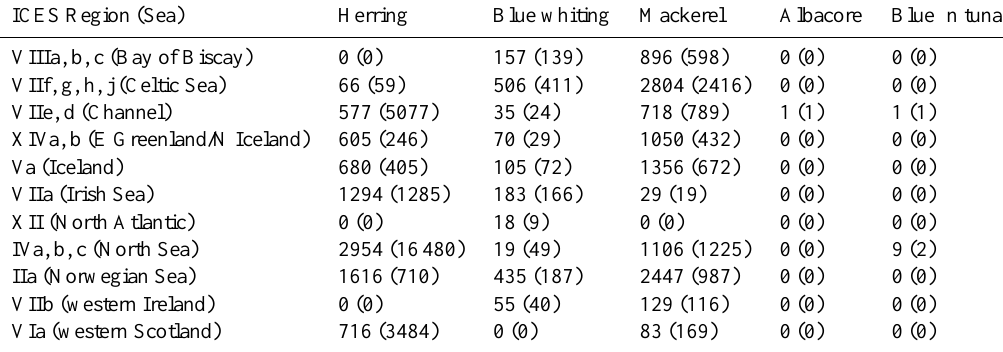
Table 2. Number of records for pelagic fish species submitted to the DAPSTOM stomach content database as part of EURO-BASIN, by geographic region. Number of individual stomachs included in